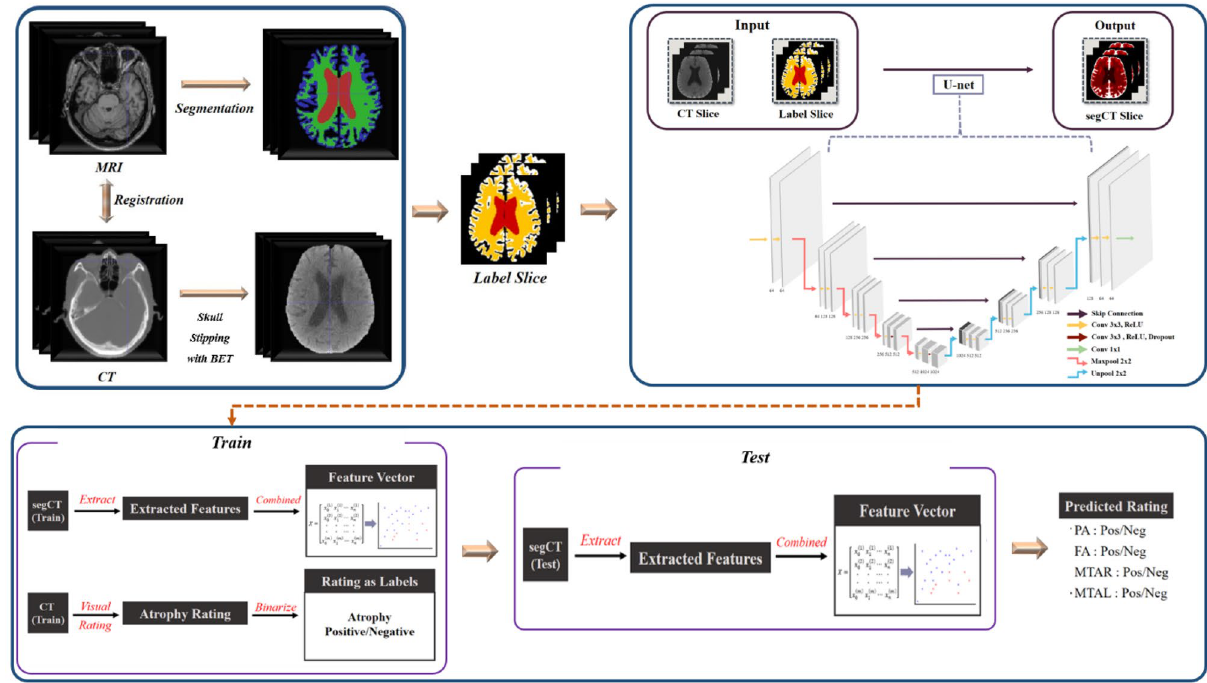
Figure 1. A scheme of framework. Tensors are indicated as boxes while arrows denote computational operations. Number of channers is indicated beneath each box. Input and output of this network are CT slice with Label slice pairs and segmented CT images (segCT) slice. The classification conducted by threefold cross- validation was performed by randomly assigned the subject into three subgroups. BET Brain extraction, ReRU rectified linear unit activation, segCT Segmented CT, RLR regularized logistic regression, FA frontal atrophy, PA Parietal atrophy, MTAR medial temporal atrophy, right, MTAL medial temporal atrophy, left, Pos positive, Neg